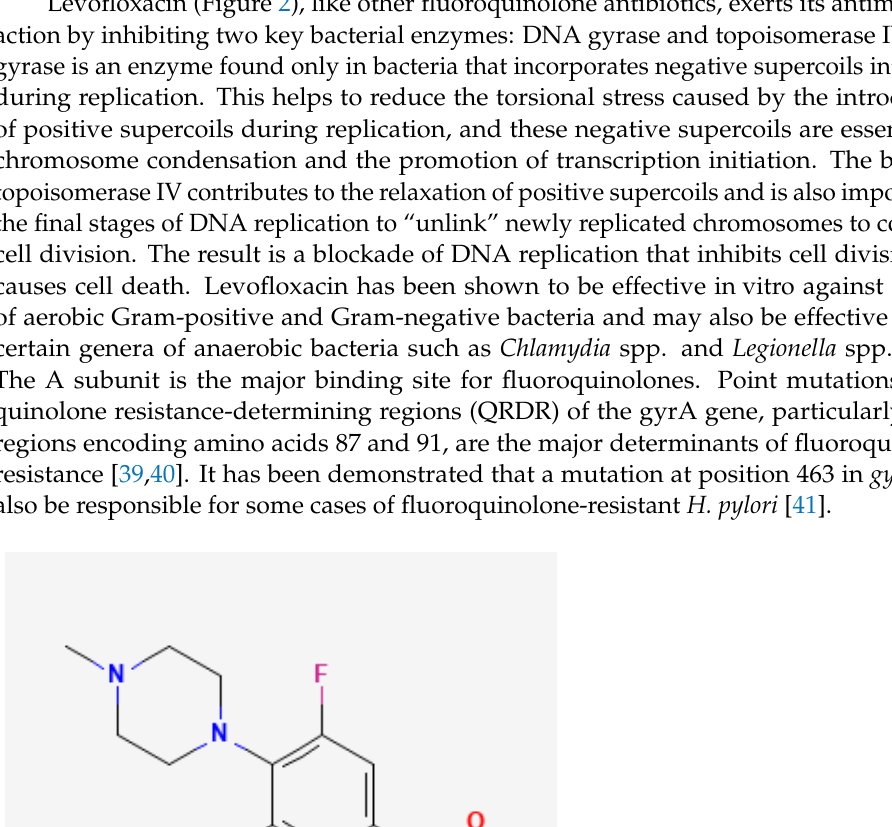
Figure 1. 2D chemical structure of clarithromycin.